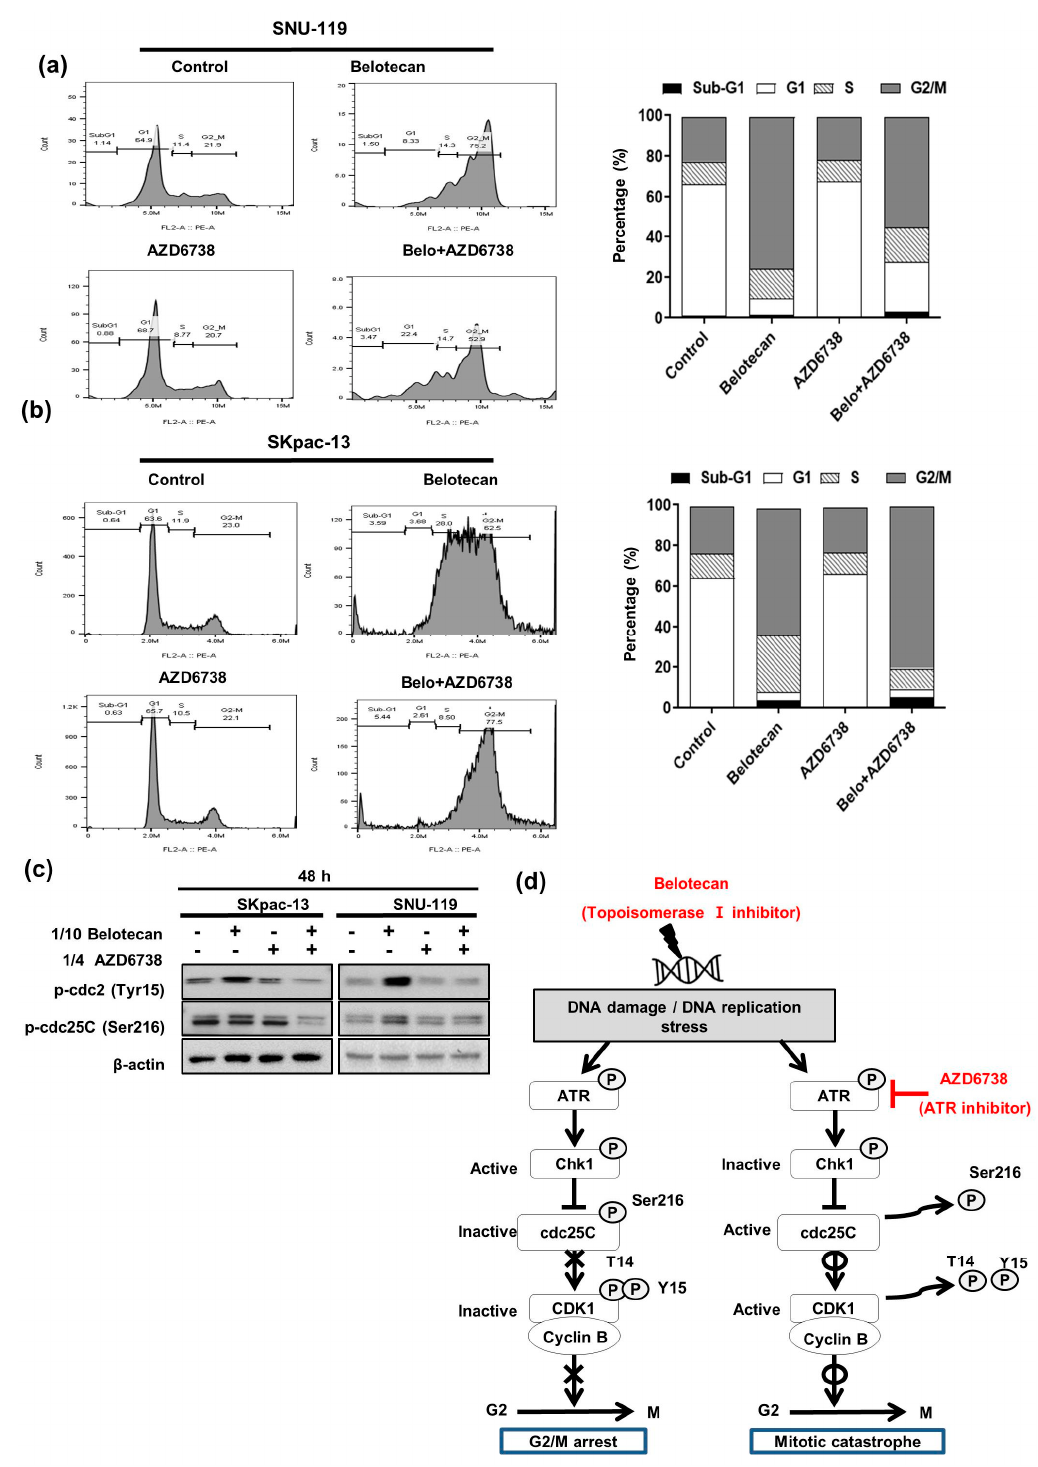
Figure 4. Mitotic catastrophe caused by AZD6738 in combination with belotecan may account for synergistic mechanisms. ( a ) Belotecan-induced G2/M arrest in the SNU-119 cells. ( b ) Belotecan-induced G2/M arrest in SKpac-13 cells. Addition of AZD6738 to belotecan led to more apoptosis, as indicated by the increased sub-G1 cell population compared to treatment with belotecan alone. ( c ) Downstream genes of Chk1, cdc25c, and phospho-CDK1 were increasingly phosphorylated with belotecan but were dephosphorylated again with the addition of AZD6738 to belotecan at 48 h. ( d ) Proposed synergistic mechanisms are depicted; belotecan-induced inhibitory phosphorylation of CDK1 causes mitotic exit, which is reversed by AZD6738, an ATR inhibitor, consequently allowing DNA-damaged cells to enter into mitosis, leading to mitotic